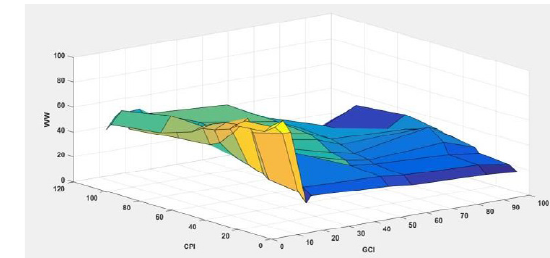
Fig. 11: The results of estimation and prediction of level of public welfare of Ukraine